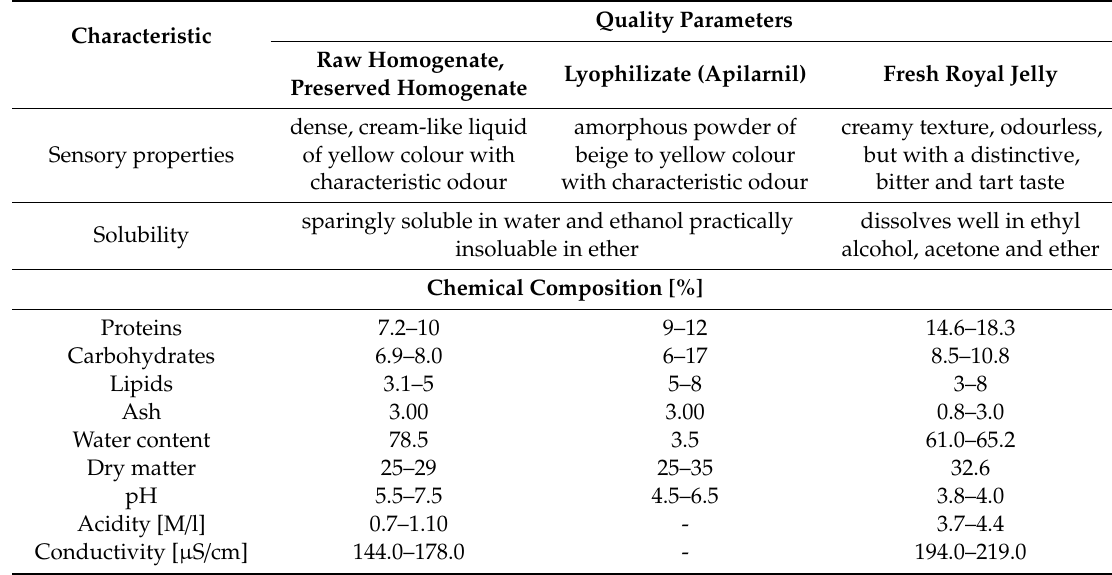
Table 1. Physical properties and chemical composition of raw drone brood homogenate in comparison with the apilarnil product [17,34–38] as well as royal jelly [35,38–40]. Quality Parameters Characteristic Raw Homogenate, Lyophilizate (Apilarnil) Fresh Royal Jelly Preserved Homogenate amorphous powder of dense, cream-like liquid creamy texture, odourless, beige to yellow colour Sensory properties of yellow colour with but with a distinctive, characteristic odour bitter and tart taste with characteristic odour sparingly soluble in water and ethanol practically dissolves well in ethyl Solubility insoluable in ether alcohol, acetone and ether Chemical Composition